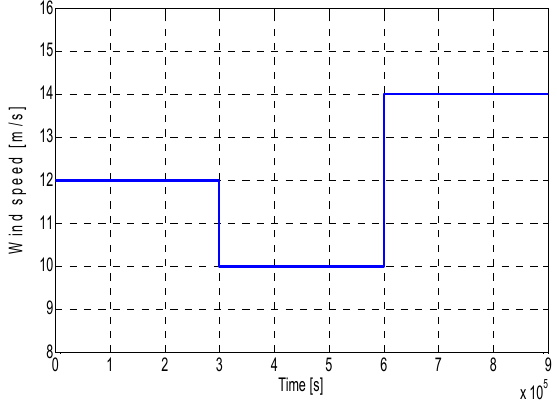
Figure 14. Adopted wind speed for simulation purposes.